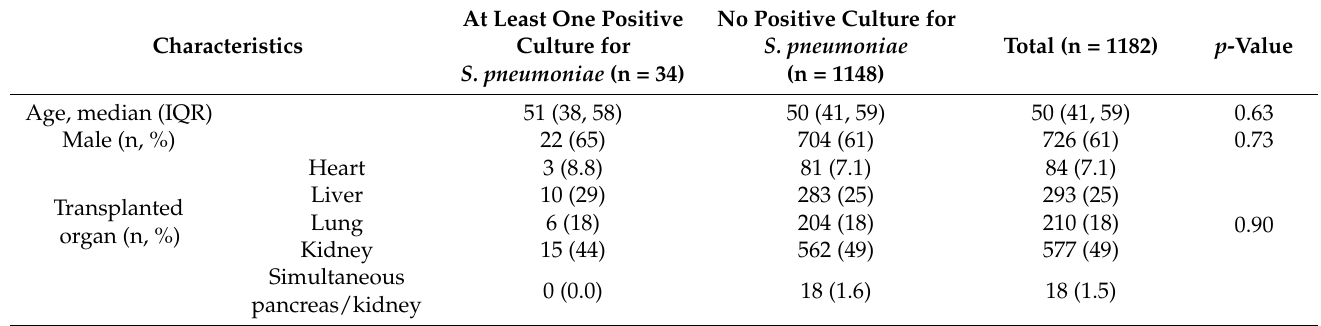
Table 1. Characteristics of solid organ transplant recipients who had and did not have at least one episode of S. pneumoniae